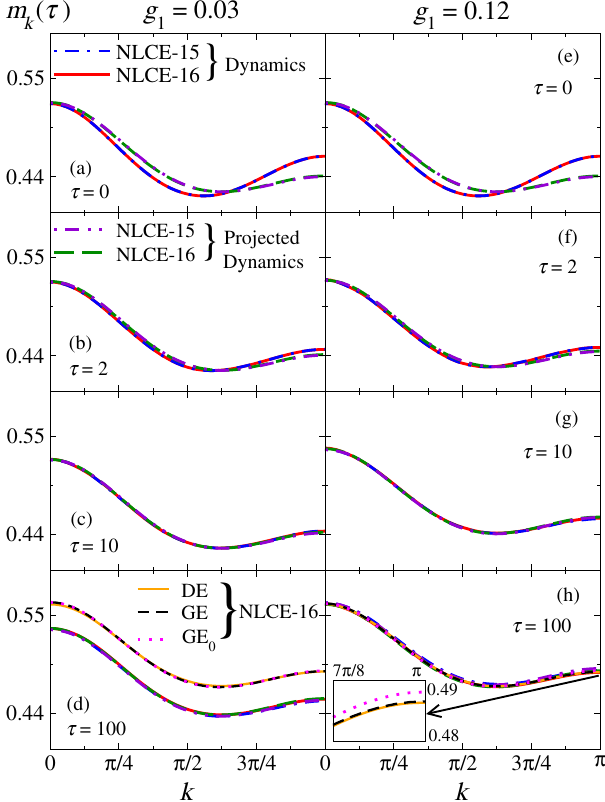
ˆ V 1 τ Þ [see Eq. (50)] at FIG. 5. Momentum distribution function m k ð ˆ H → ˆ H 0 . 03 [(a) – four times after quenches in which 1 with g 1 ¼ I τ Þ is evaluated at τ ¼ 0 [(a),(e)], (d)] and g 1 ¼ 0 . 12 [(e) – (h)]. m k ð τ ¼ 2 [(b),(f)], τ ¼ 10 [(c),(g)], and τ ¼ 100 [(d),(h)]. Results are reported for the 15th (NLCE-15) and 16th (NLCE-16) orders of τ Þ for the dynamics [see the legends in the NLCE. We show m k ð ˆ H (a)], and for the projected dynamics in the basis of 0 [see the legends in (b)]. The predictions of the diagonal ensemble (DE) and the grand canonical ensemble (GE) for the dynamics, and of the grand canonical ensemble for the projected dynamics (GE 0 ), all evaluated at the 16th order of the NLCE, are shown in (d) and (h) [see the legends in (d)]. The inset in (h) shows the predictions of the latter three ensembles about k ¼ π .